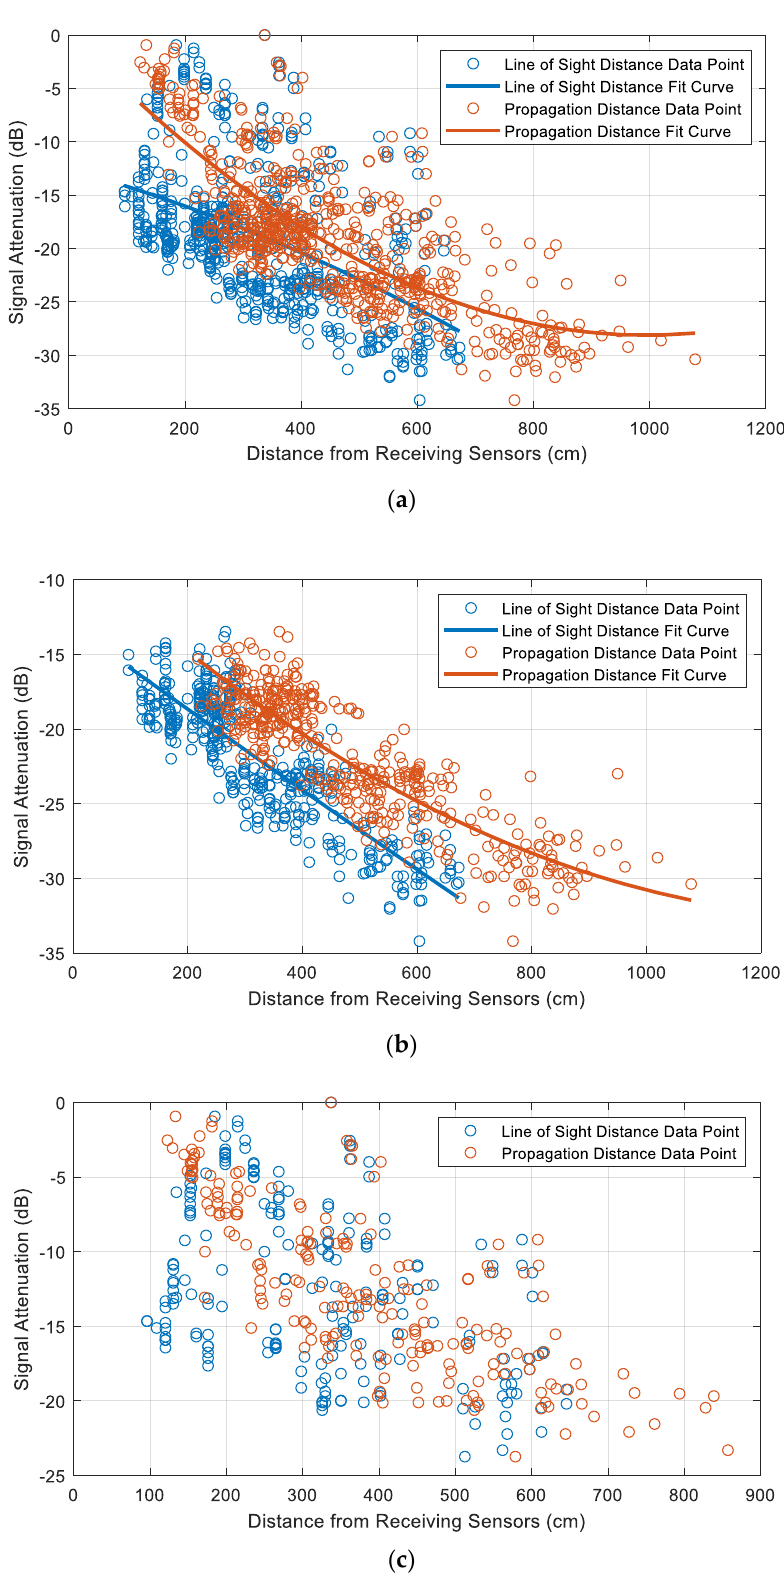
Figure 9. Comparison of Line-of-Sight distance and propagation distance-dependent attenuation in the transformer model using the reference winding design ( a ) All artificial PD sources; ( b ) PD sources inside winding; ( c ) PD sources outside winding.